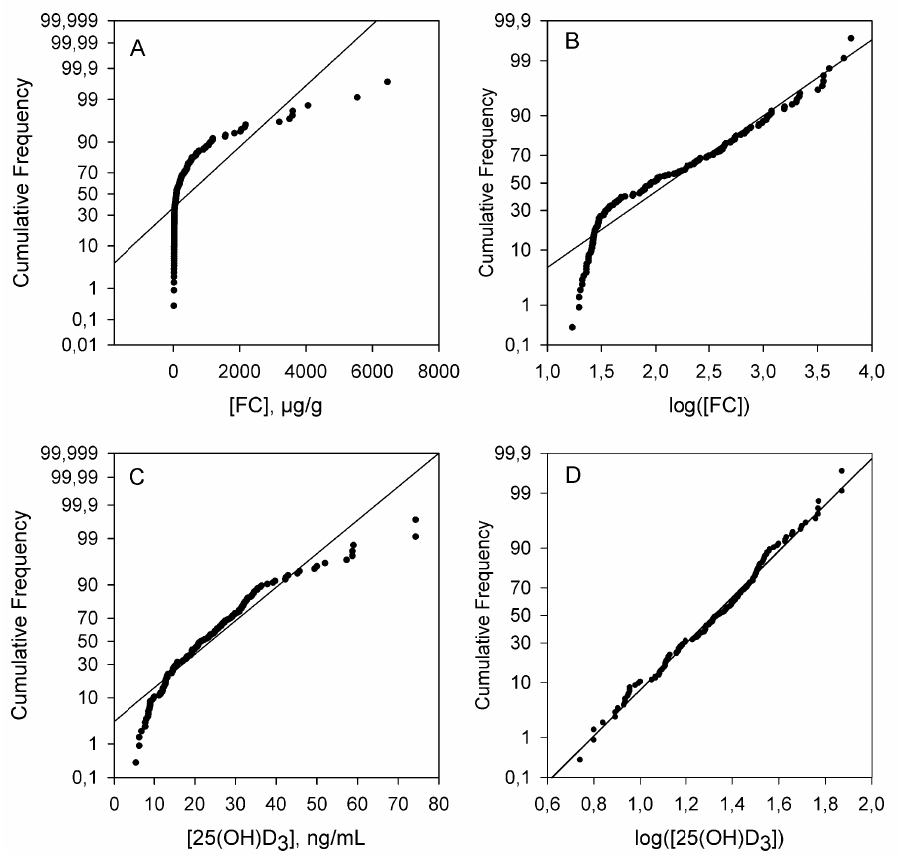
Figure 3. Normality study of FC ( A , B ) and vitamin D ( C , D ). Note the nonparametric distribution of FC. Table 3. Baseline clinical characteristics of patients meeting inclusion criteria.